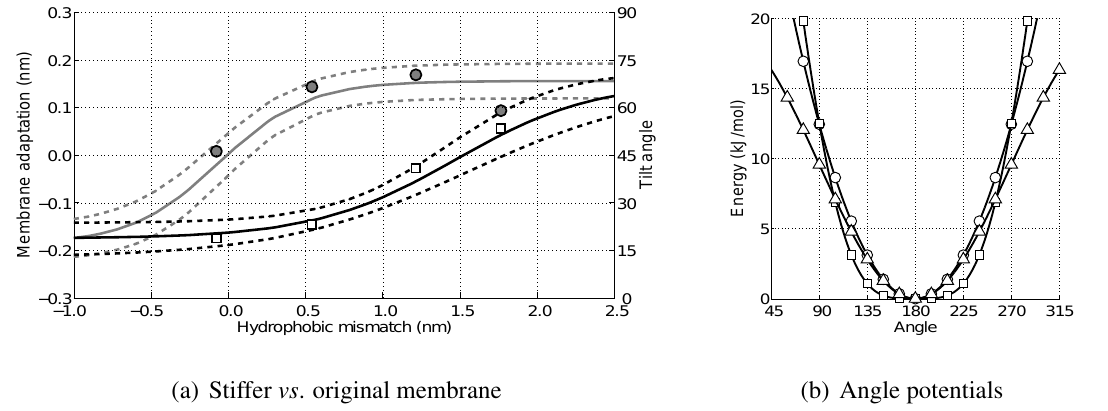
Figure 11. In (a) the data shown in Figure 10 is repeated using only the sigmoid curves (solid lines). The dotted lines are used to indicate the bandwidth (plus or minus the standard deviation) for both the membrane adaptation (left axis) and the peptide tilt (right axis) as a function of the hydrophobic mismatch. The circles and squares are the values computed from the stiffer membrane. In (b) three lipid tail angle potentials from different CG models are shown (a square denotes Marrink’s model, a triangle Klein’s, and a circle the current